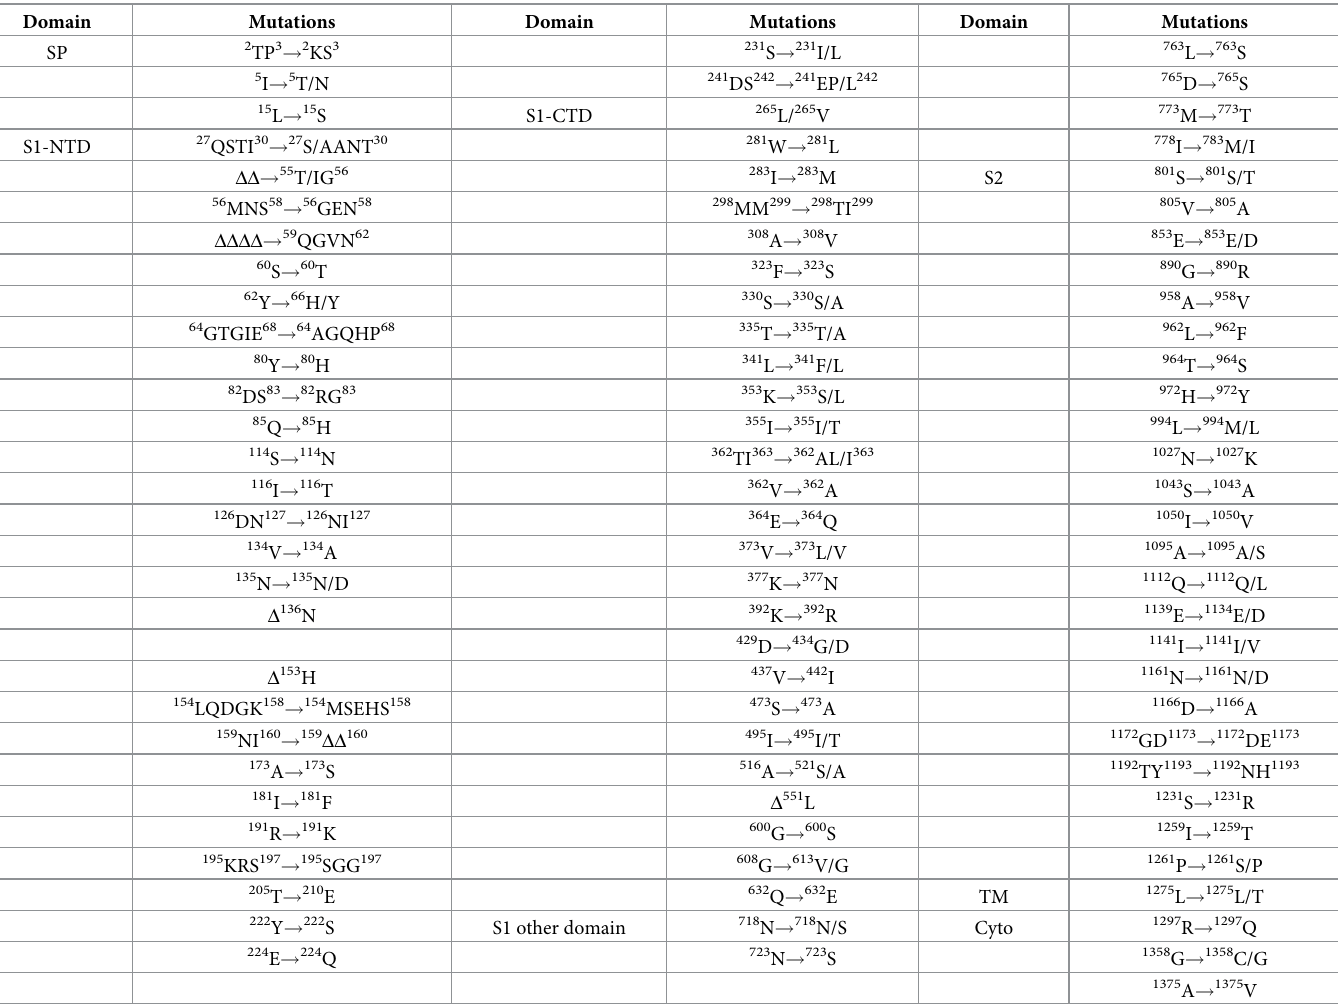
Table 5. Statistics of mutations in the S protein of the 13 PEDV strains in comparison with ZJ08.